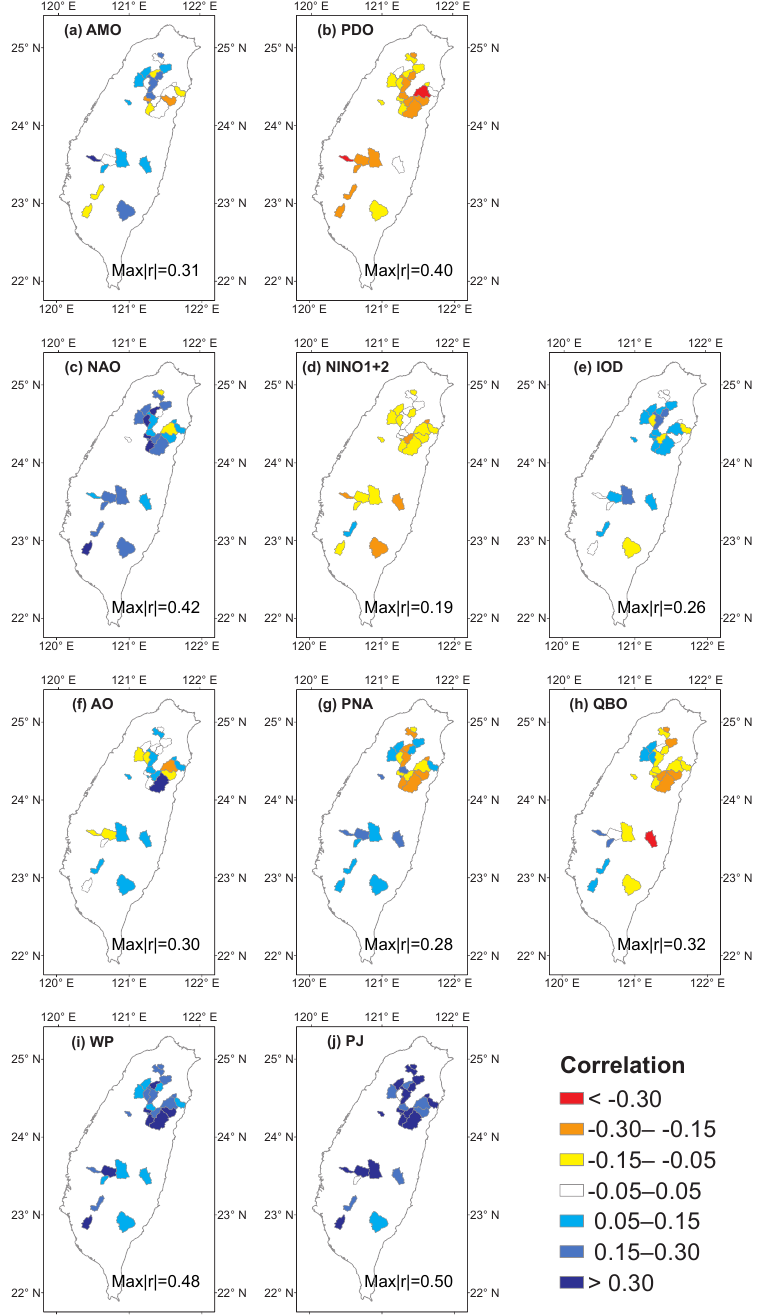
Figure 2. Maps of concurrent correlations showing each upstream catchment. The maximum absolute correlation value among all the catchments is denoted at the bottom of each